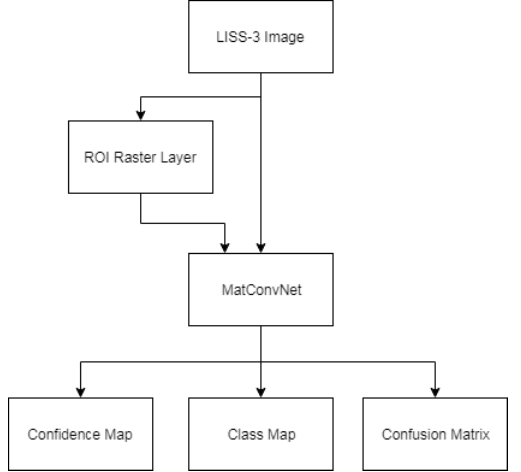
Actual | Predicted